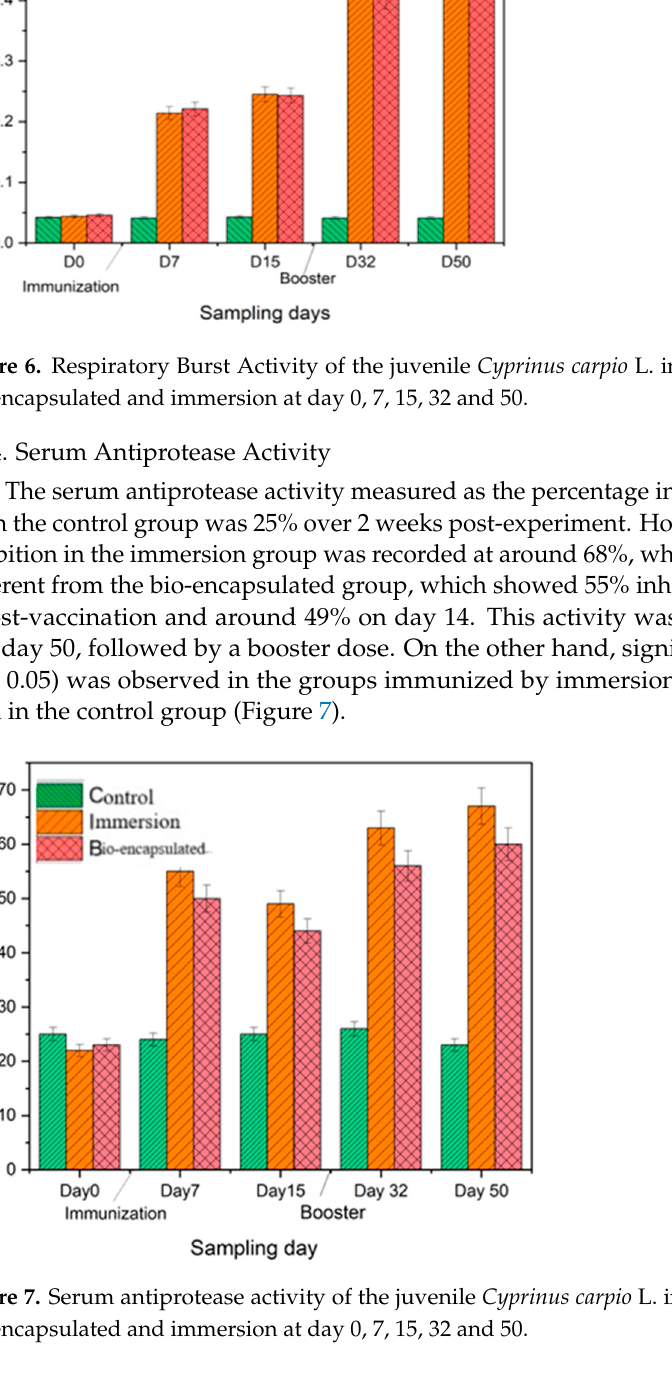
9 of 19 Figure 5. Serum lysozyme activity of the juvenile Cyprinus carpio L. in all three groups, control, bio- encapsulated and immersion at day 0, 7, 15, 32 and 50.